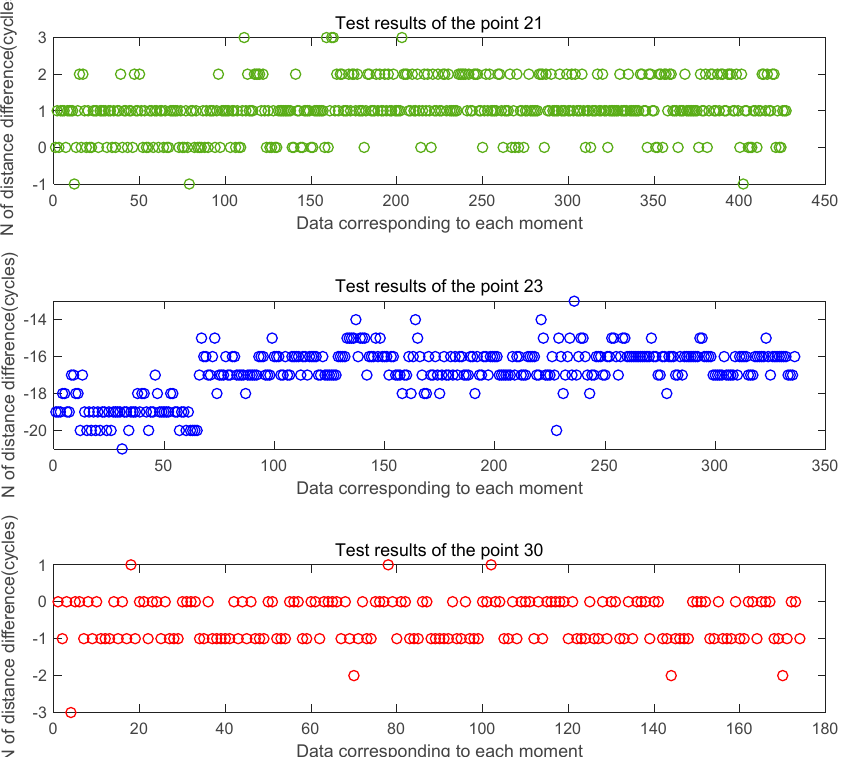
Sensors 2020 , 18 , x FOR PEER REVIEW Figure 13. Estimated distance di ff erence N at the three feature points in the second set of tests. Figure 13. Estimated distance difference N at the three feature points in the second set of tests.